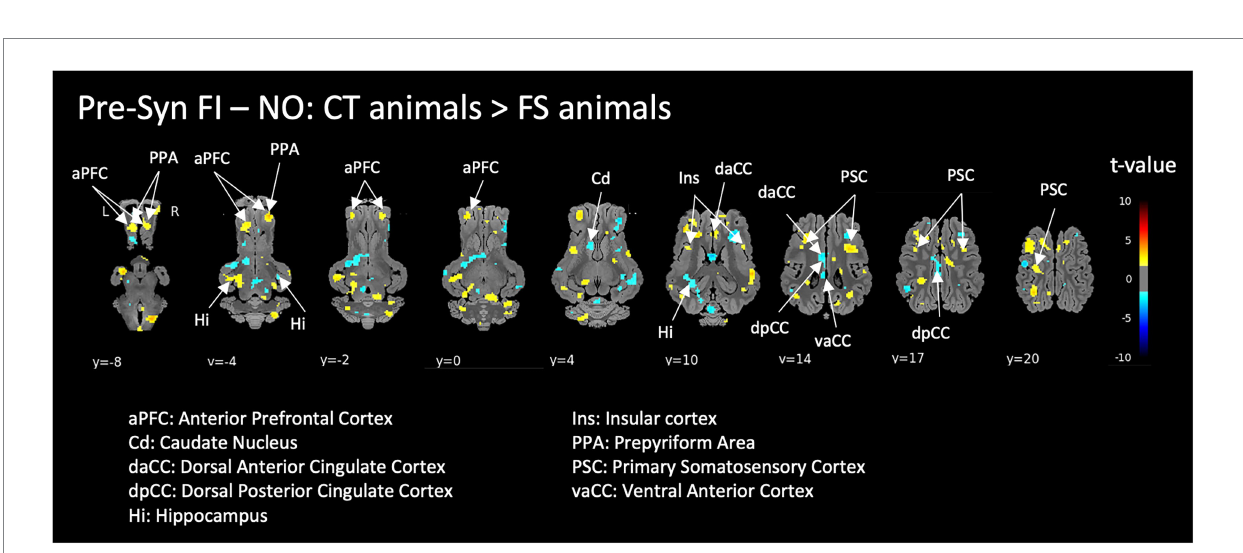
FIGURE 4 Responses to the functional ingredient (FI compared to non-odorized air, NO) in naive control animals (CT) compared to FI-habituated animals (FS) before (Pre-Syn) induction of the acute pharmacological stress (injection of Synacthen®). Horizontal maps of brain BOLD responses are represented at different dorsal-ventral levels ( y ) related to the posterior commissure (in mm). Value of p threshold = 0.05, k > 20 (number of voxels per